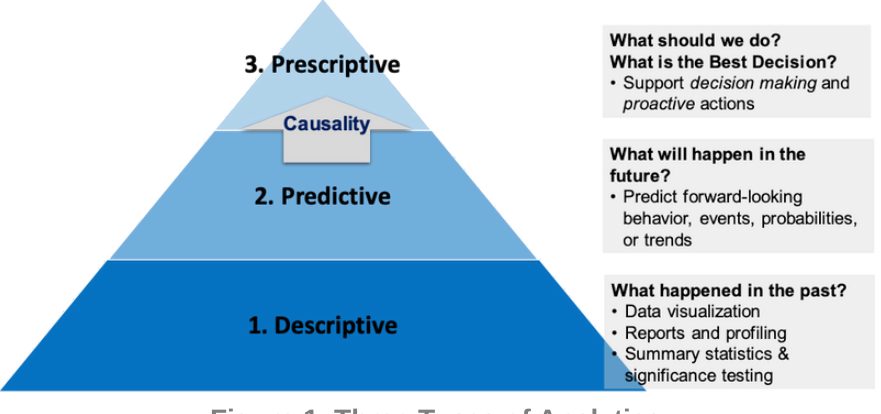
Figure 1. Three Types of Analytics